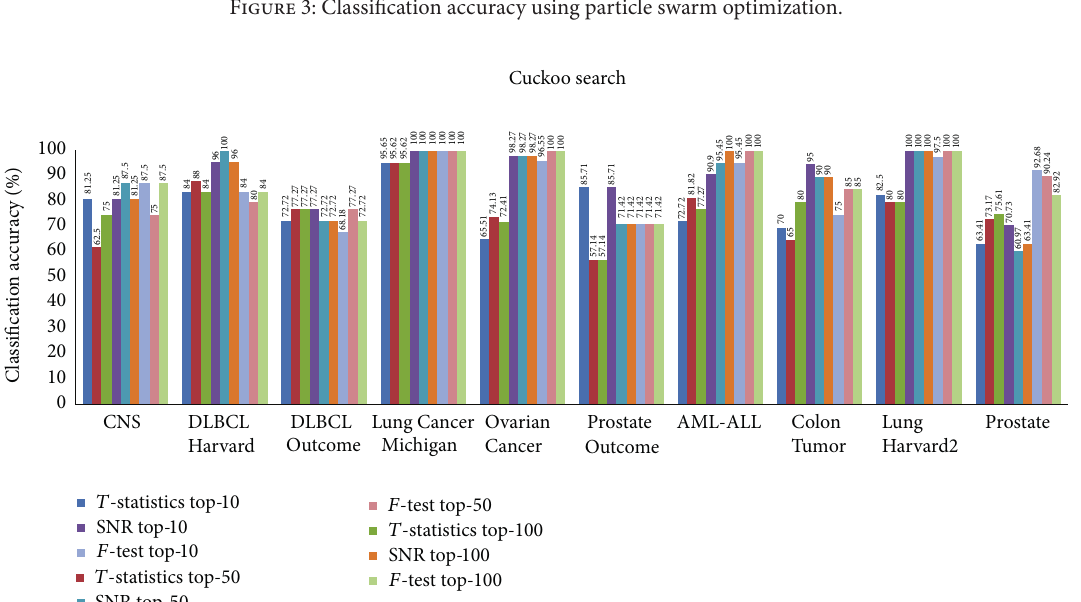
Figure 3: Classification accuracy using particle swarm optimization.